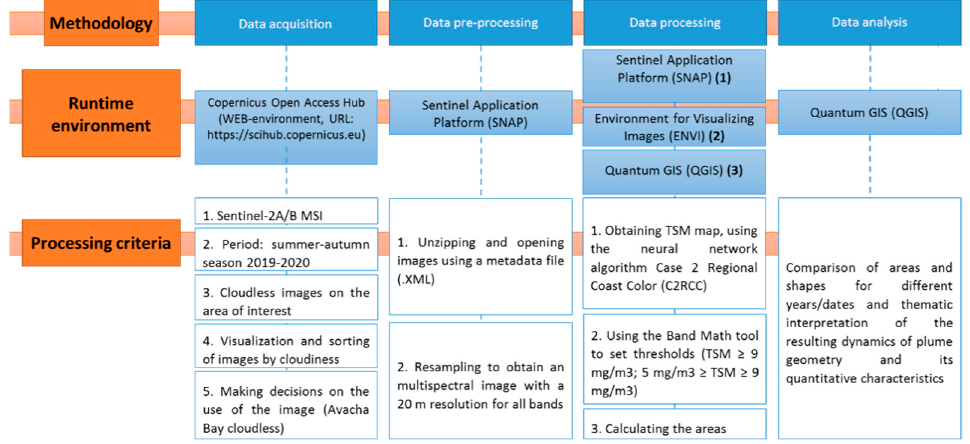
Figure 4. Flowchart of the experiment for processing Sentinel ‐ 2A/B multispectral imagery.